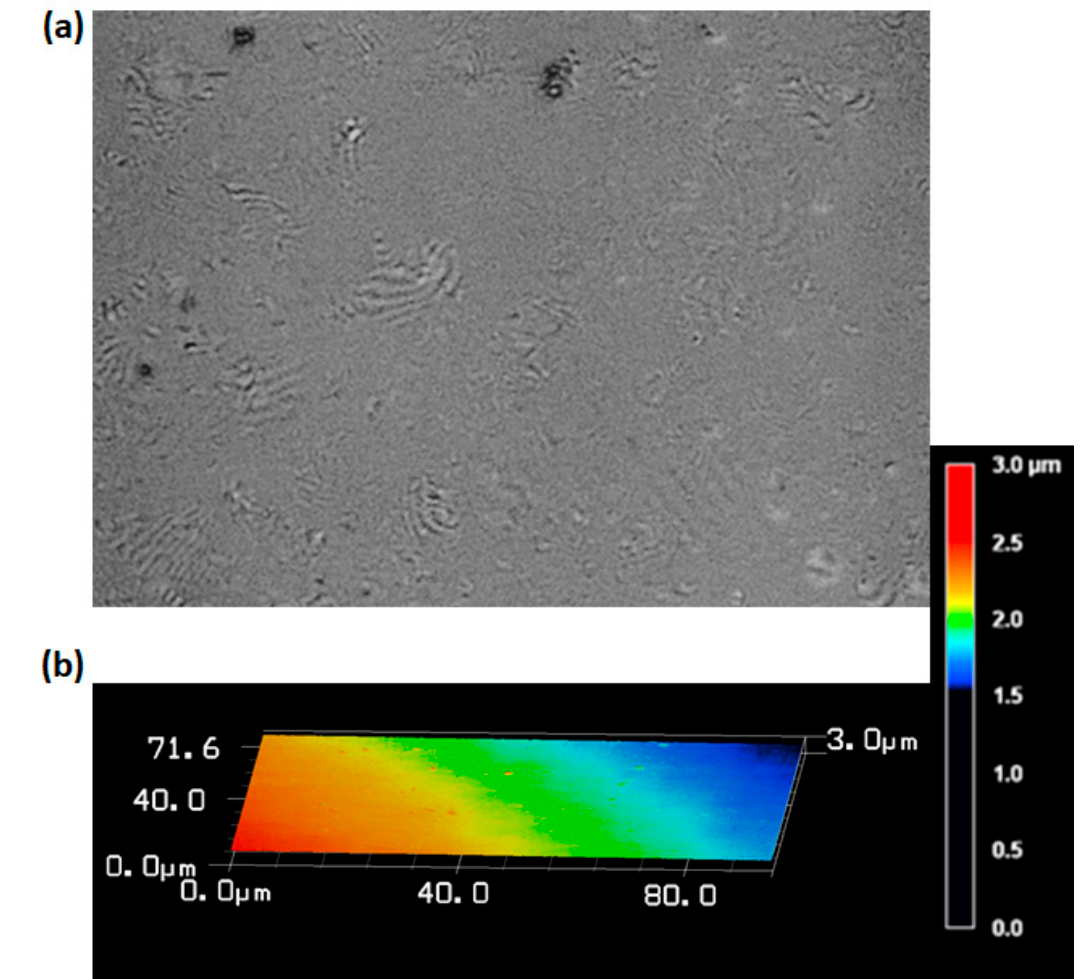
Figure 4. ( a , b ) The optical microscopic image and roughness profile of the SR film deposited on the glass plate, respectively.